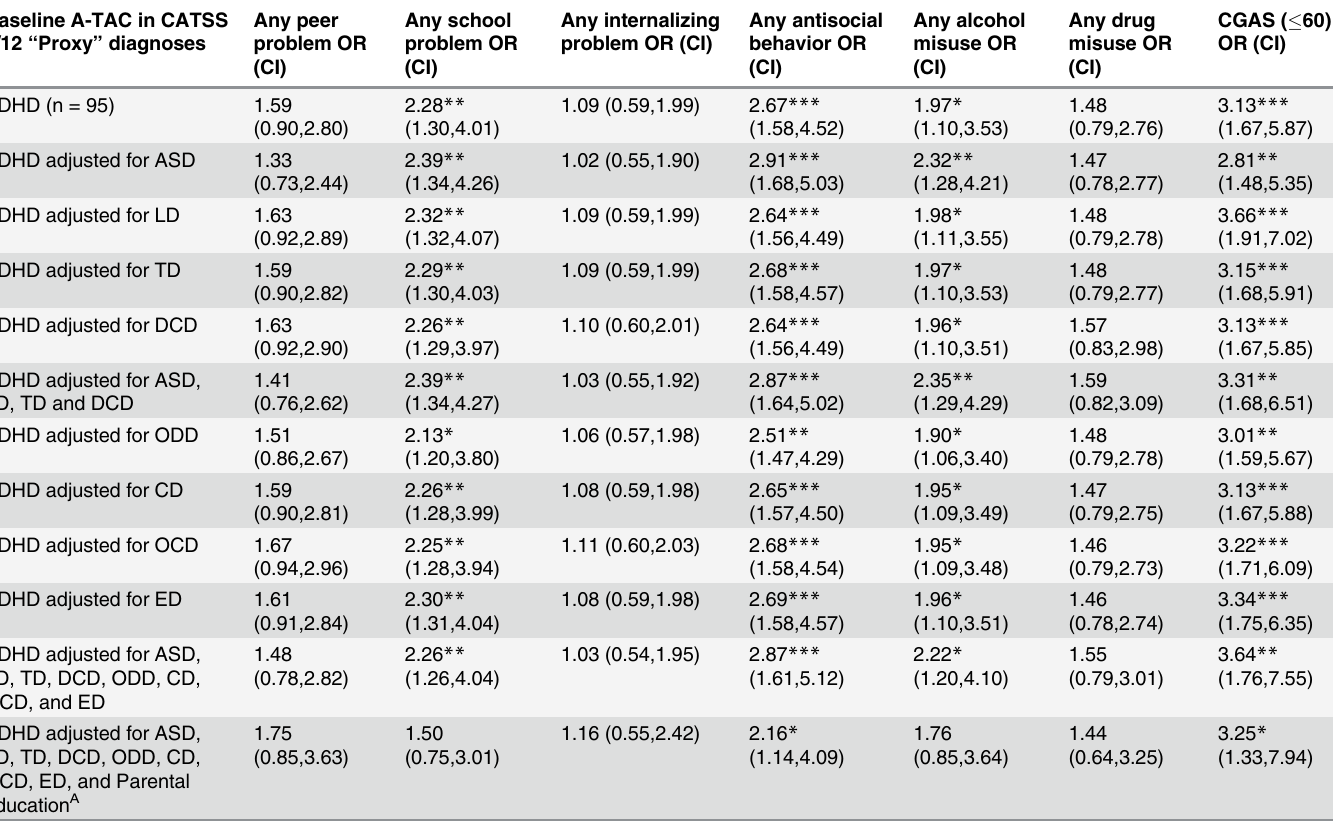
Table 5. Logistic Regression Analyses of the Associations of ADHD at Age 9/12 and Seven Psychosocial Outcomes at Age 15. Baseline A-TAC in CATSS 9/12 “ Proxy ”